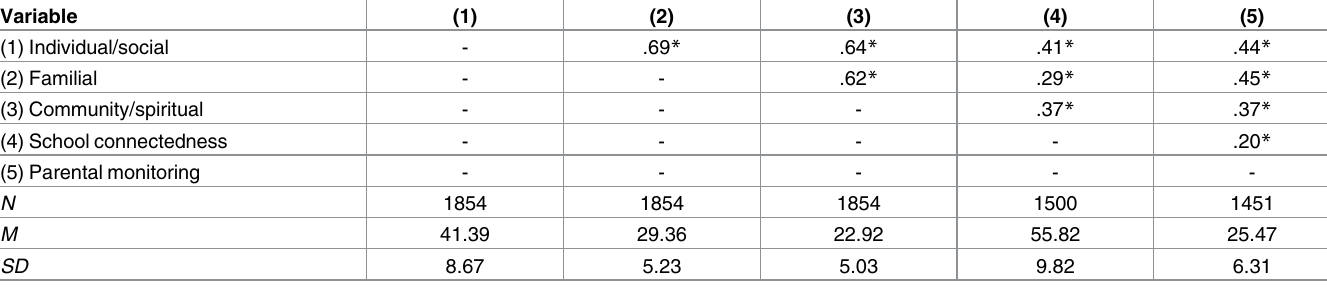
Table 4. Pearson correlations between the CYRM, school connectedness, and parental monitoring scales. Variable